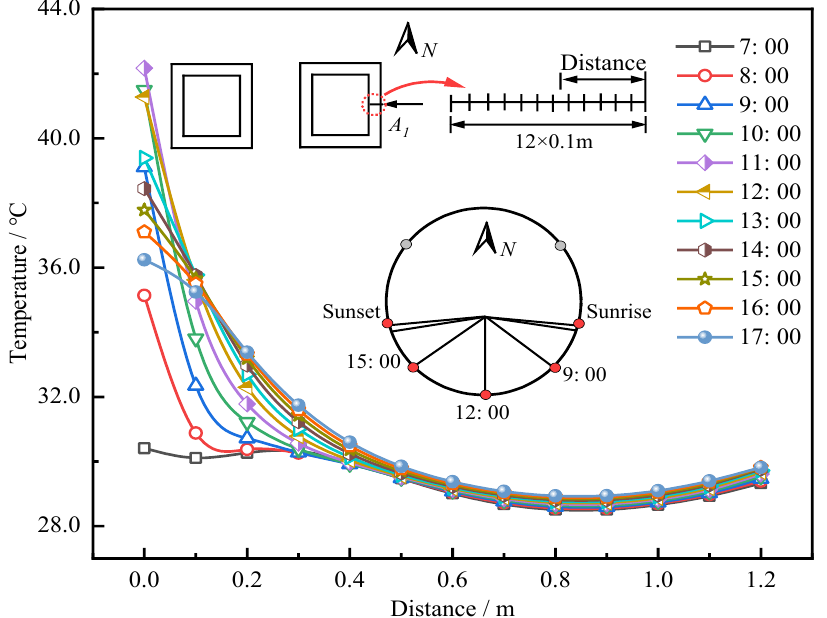
Figure 24. The temperature variation curve in the thickness direction of the east tower wall at a 125 m height during the day.